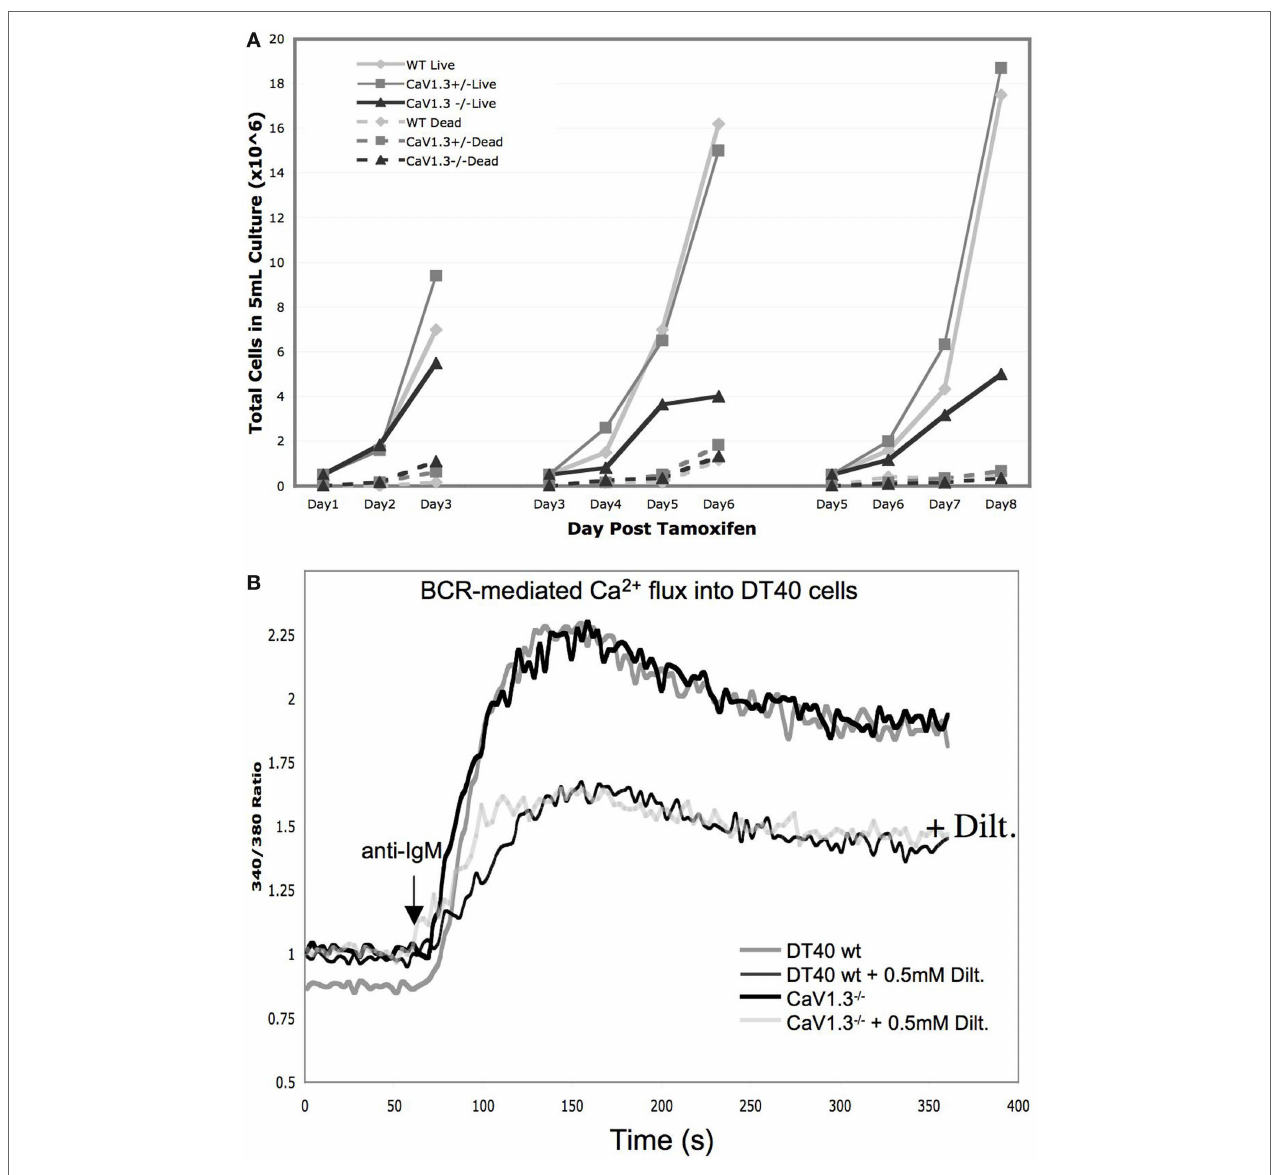
represent the corresponding numbers of dead cells as determined by trypan blue in the same cultures. Cells were split back every 3 days to 0.5 × 10 6 /ml. (B) Ca 2 + -transients in wt vs. Ca V 1.3-deficient DT40 cells following BCR- activation with or without L-type channel blocker